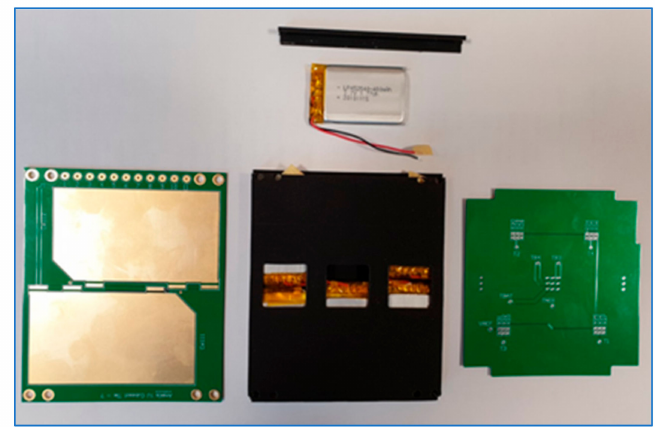
Figure 8. Mockup of the proposed